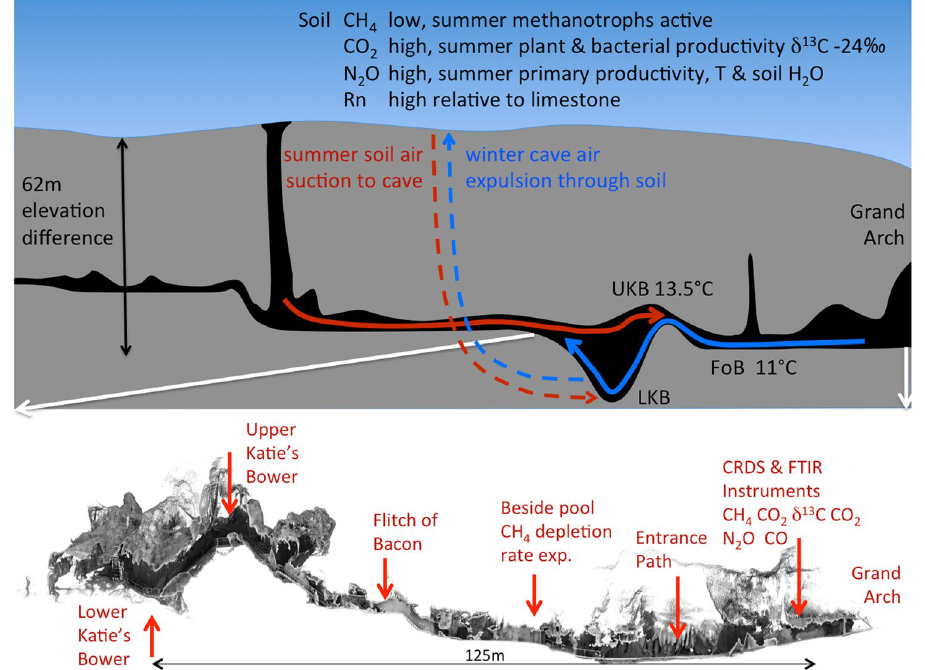
Figure 1. Top panel is a schematic cross-section through Chifley Cave showing the dominant convective air- flow directions for summer (red) and winter (blue). Air-flow along major passages may reverse direction daily in response to a reversal of the cave to external temperature difference, without a time lag ( < 15 mins). The slower passage of air from soil to cave along small cracks and fissures in summer has a longer time lag of 1–6 hrs between cave - external temperature reversal and the soil air peak in Lower Katies Bower (low CH 4 , high CO 2 , high N 2 O, high Rn). Lower panel is a scale diagram of continuous flow air sampling locations relative to the CRDS & FTIR